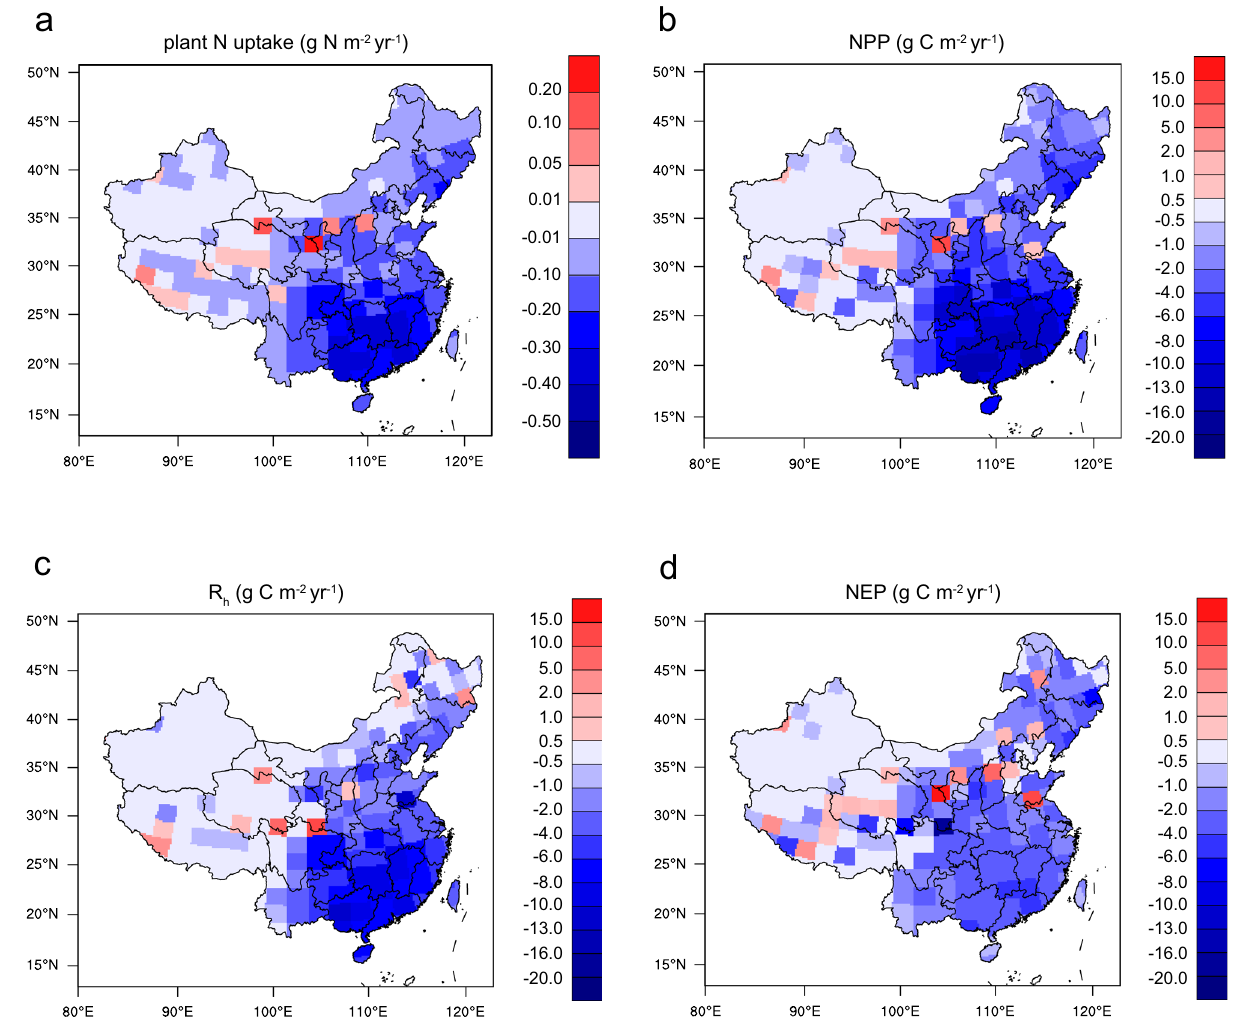
Fig. 4 Changes in ecosystem carbon balance caused by a 30% reduction of NO x emission. Four variables associated with plant growth and carbon sequestration are provided by a land ecosystem model (CLM5): a plant N uptake, b net primary production (NPP), c heterotrophic respiration (R h ), and d net ecosystem production (NEP). The map of China was reproduced from the National Geographic Information Resource Directory Service